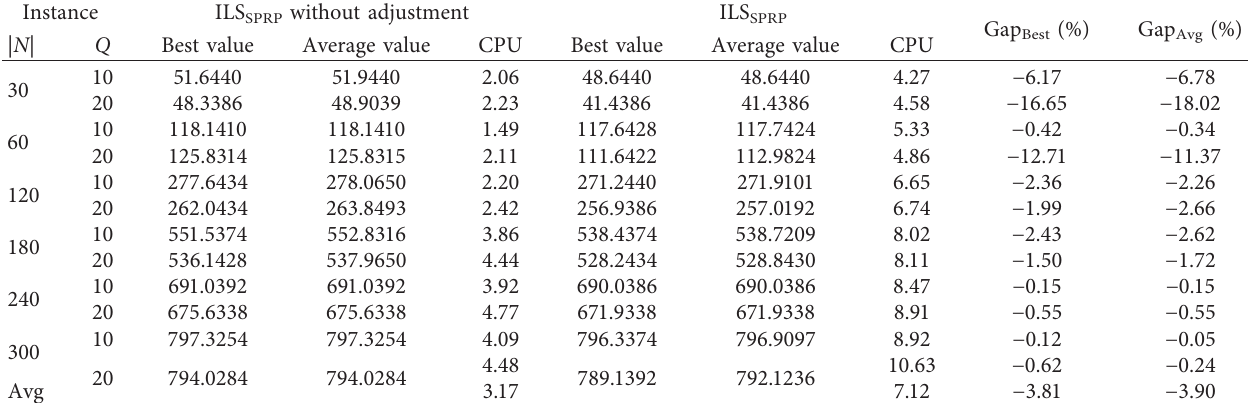
Table 6: Result comparison of ILSSPRP with and without the adjustment operator ( T � 14400s).